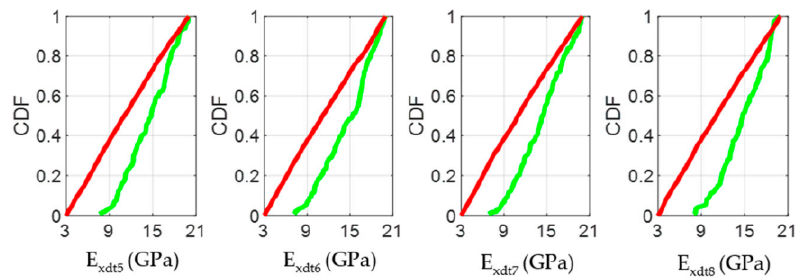
Figure 13. Cumulative Distributions Functions (CDFs) of the four input factors located in the central third of the timber board # 33 ( E xdt in zones 5 to 8) for the output metric (Y function). The green and red curves represent the sets B (behavioral) and NB (non-behavioral), respectively.